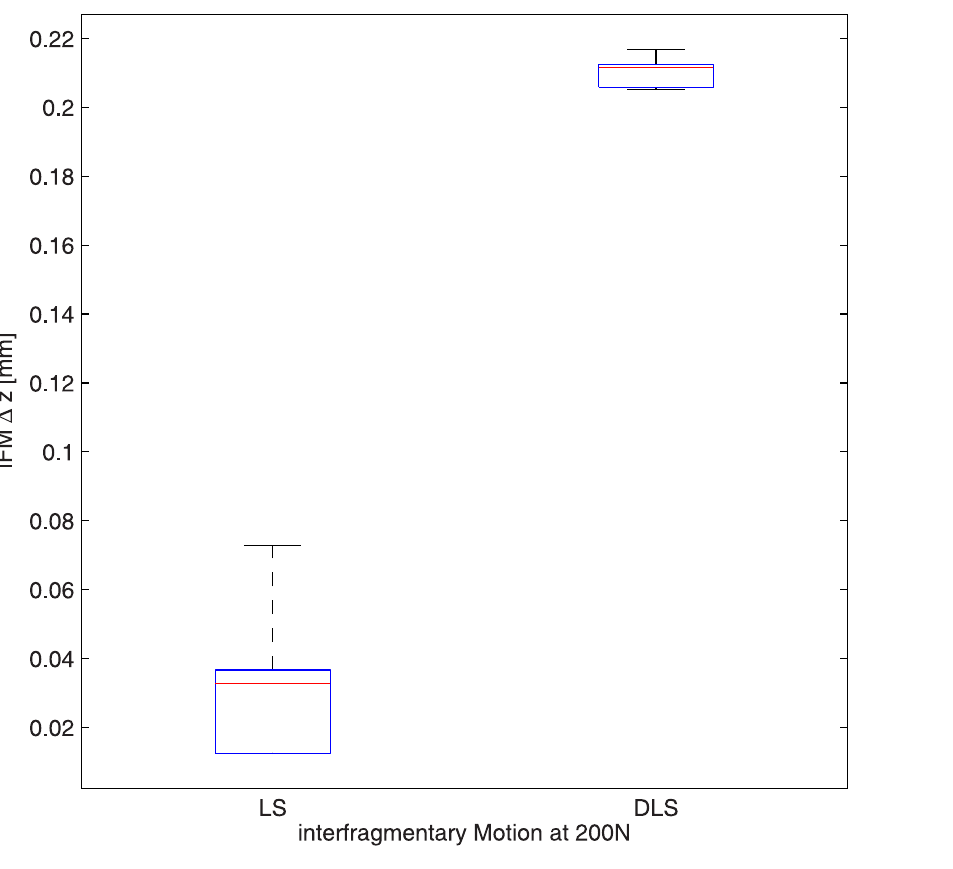
Figure 7. With application of a 200 N axial load, the interfragmentary motion at the near cortex was significantly higher in the DLS group (0.210 mm; SD ± 0,004 mm) (compared to the LS group (0.033 mm; SD ± 0.02 mm).